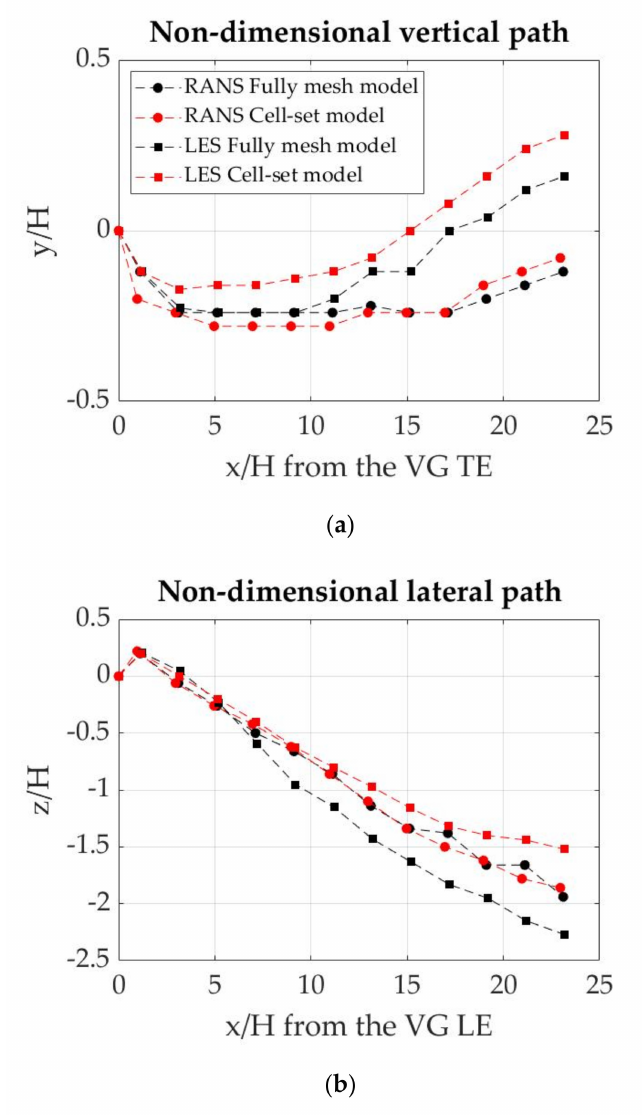
Figure 7. Non-dimensional trajectory of the primary vortex: ( a ) Non-dimensional vertical path; ( b ) Non-dimensional lateral